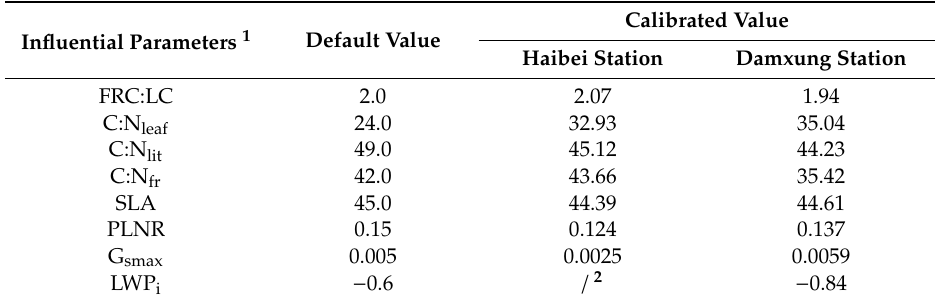
Table 3. The influential ecophysiological parameters and its calibrated values for Haibei Station and Damxung Station.